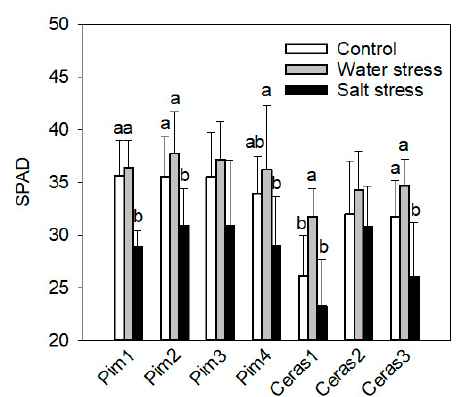
Figure 4. Soil Plant Analysis Development (SPAD) chlorophyll meter values in accessions Pim1, Pim2, Pim3, Pim4, Ceras1, Ceras2, and Ceras3 under control, water stress and salt treatment after 120 days of treatment. Data are mean values ± SE for n = 8 plants. Within each accession, di ff erent letters indicate significant di ff erences at p < 0.05 (LSD test). Analysis of two-way ANOVA is provided in supplementary material in Table S3. SE: Standard